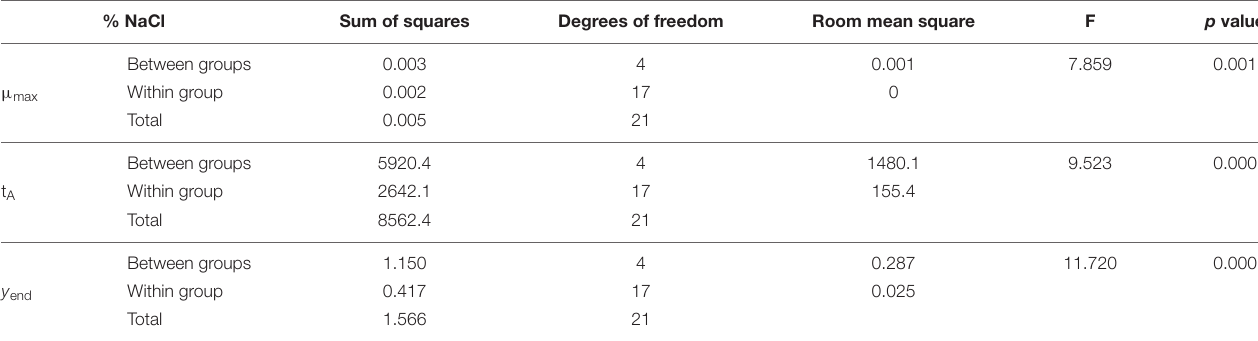
TABLE 3 | One-way ANOVA for % NaCl on the kinetic parameters of Vibrio spp. % NaCl Sum of squares Degrees of freedom